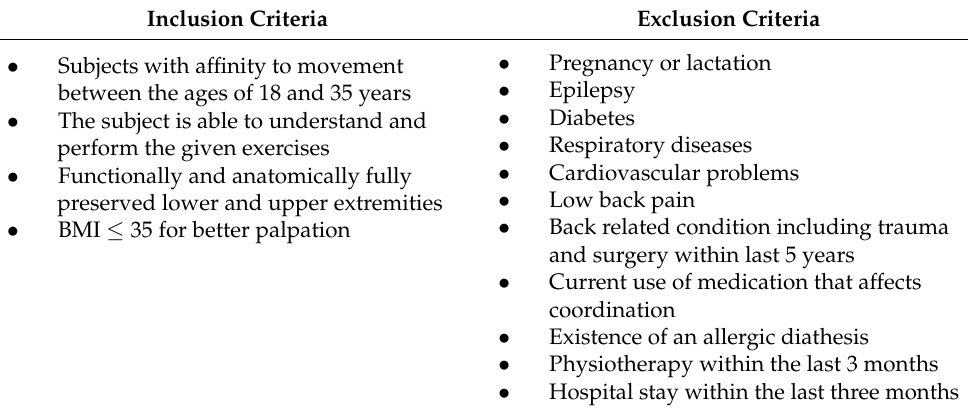
Table 2. Inclusion and exclusion criteria employed the selection of test subjects.